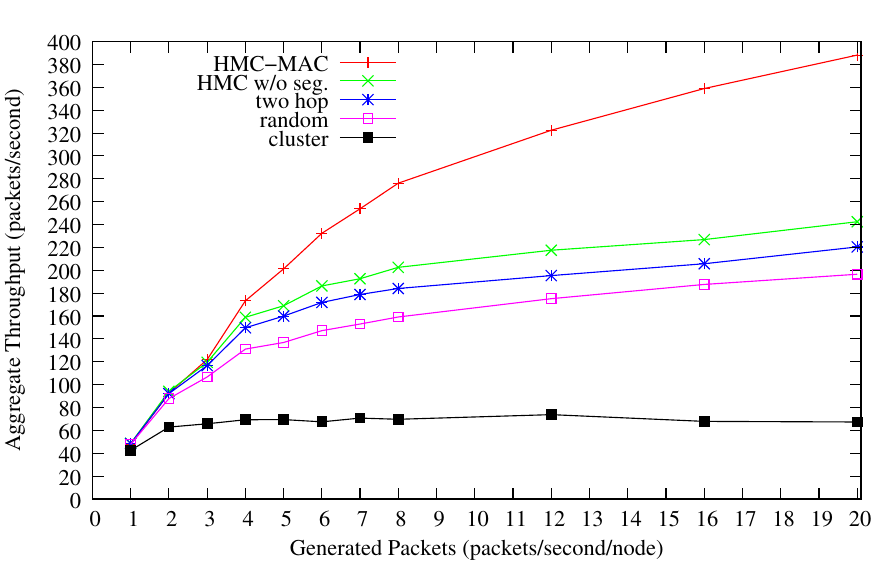
Figure 8. Aggregate throughput for burst